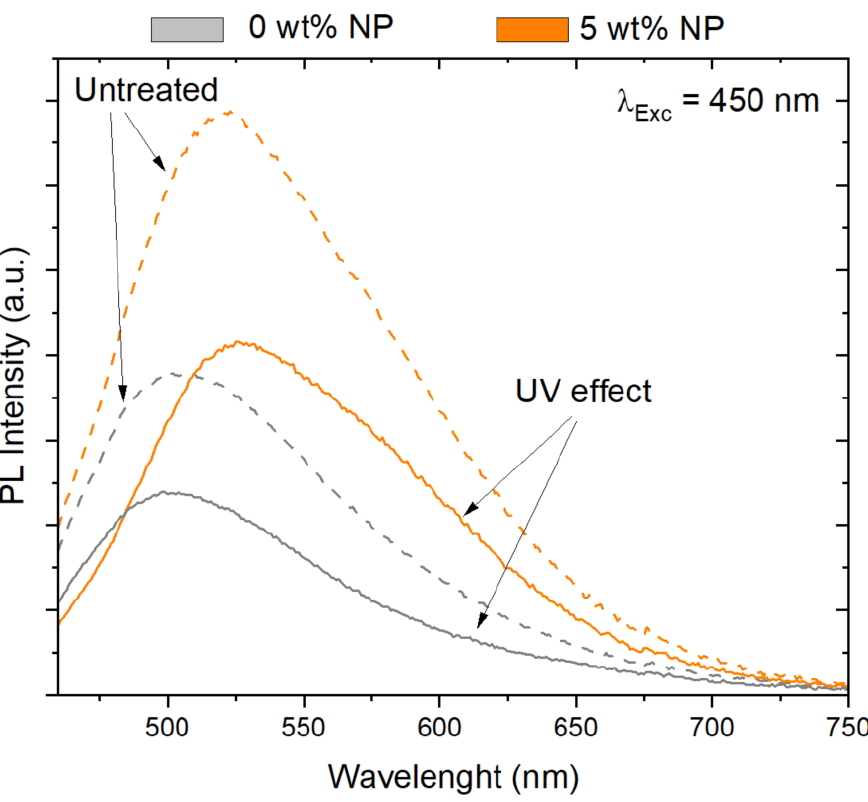
Figure 9. PL spectra of samples with 0 and 5 wt.% NP before (discontinuous line) and after UV treatment (continuous line).